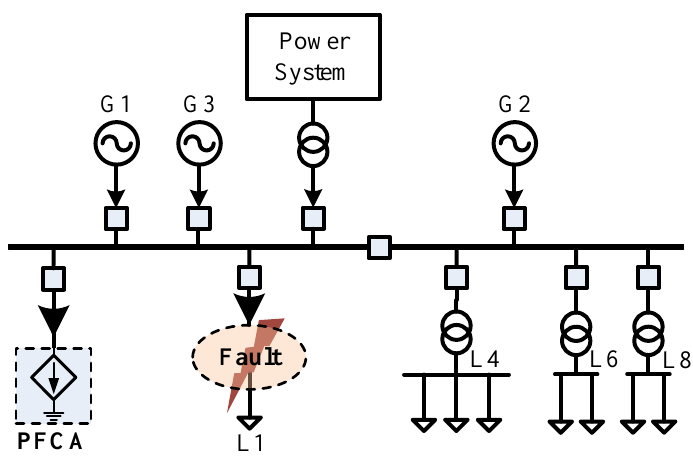
Figure 7. Simplified power distribution system with a three-phase fault.